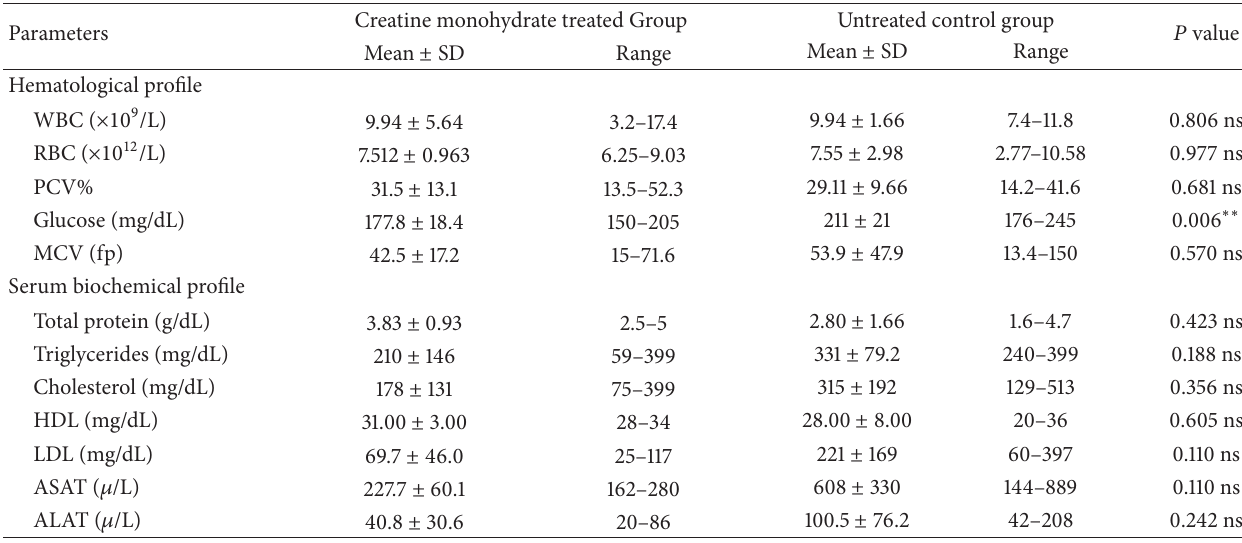
Table 3: Comparison of various hematological and serum biochemical parameters between 2% creatine monohydrate treated and untreated (control) male albino mice for 15 weeks following hypoxia and ischemia: data is expressed as mean ± standard deviation.